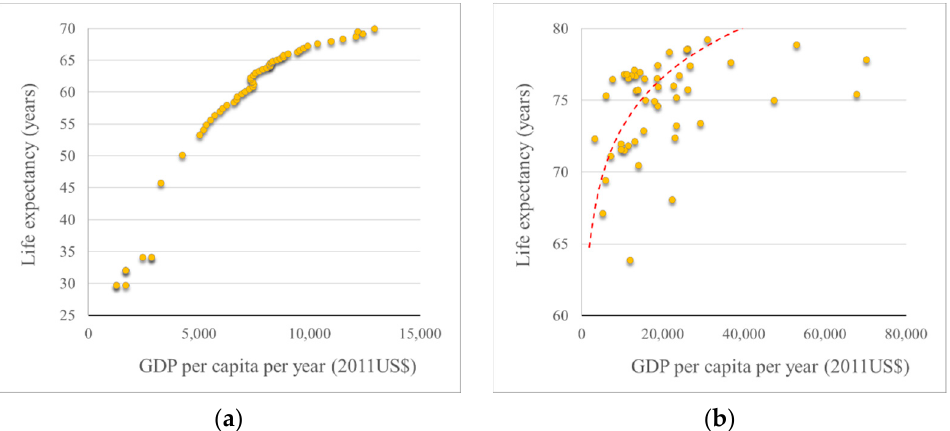
Figure 1. GDP per capita per year related to life expectancy; ( a ) global average through 1870–2011; ( b ) average per country in 2018 [58].